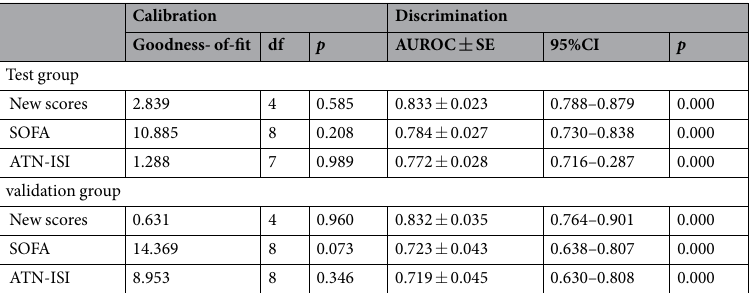
Table 7. Calibration and discrimination for the scoring methods in predicting 90-day mortality of patients with AKI diagnosis. Abbreviation: AKI, acute kidney injury; df, degree of freedom; AUROC, areas under the receiver operating characteristic curve; SE, standard error; CI, confidence interval; ATN-ISI: acute tubular necrosis- individual severity index; SOFA: sequential organ failure